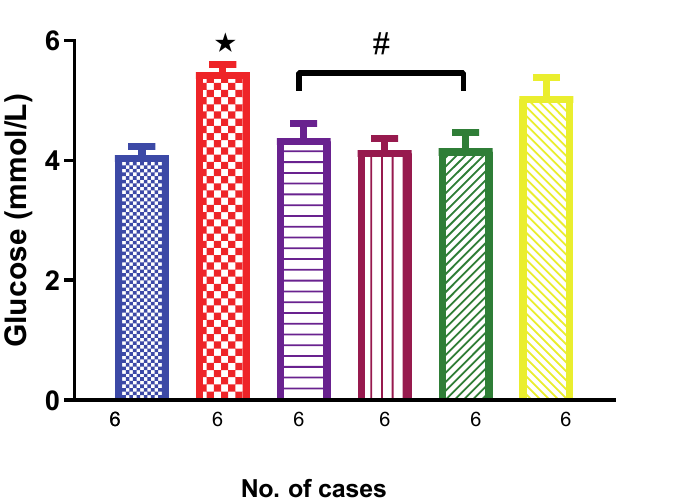
Figure 1. Glucose levels in normal control (NC), prediabetic control (PD), metformin and diet intervention (MET + DI), metformin and high-fat/high-carbohydrate diet (MET + HFHC), rhenium (V) compound and diet intervention (Re + DI) and rhenium (V) compound and high-fat/high-carbohydrate diet (Re + HFHC) groups after 12 weeks of treatment. Values are presented as means ± SEM (n = 6). (cid:70) p < 0.05 in comparison with NC; # p < 0.05 in comparison with PD, MET + DI, MET + HFHC, Re + DI and Re + HFHC.